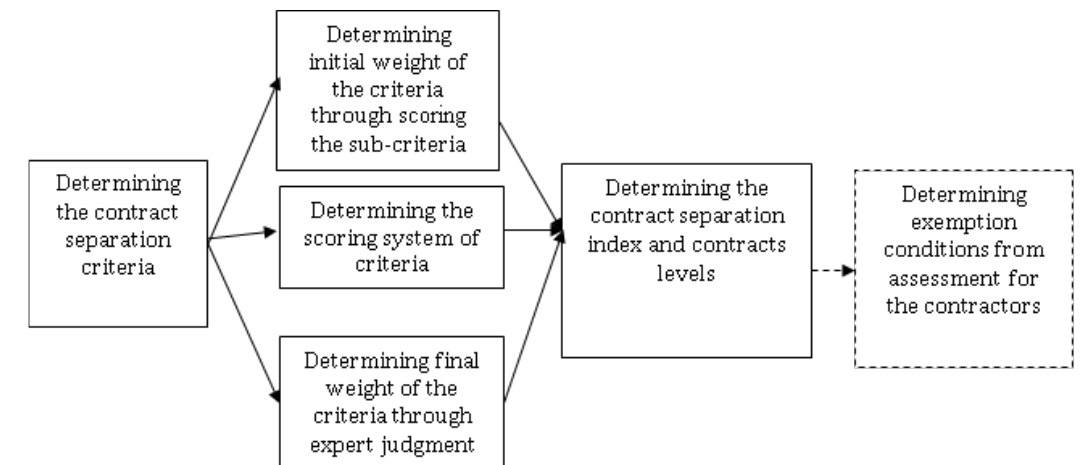
Figure 1. Methodological research design for developing the contract separation Index based on HSE